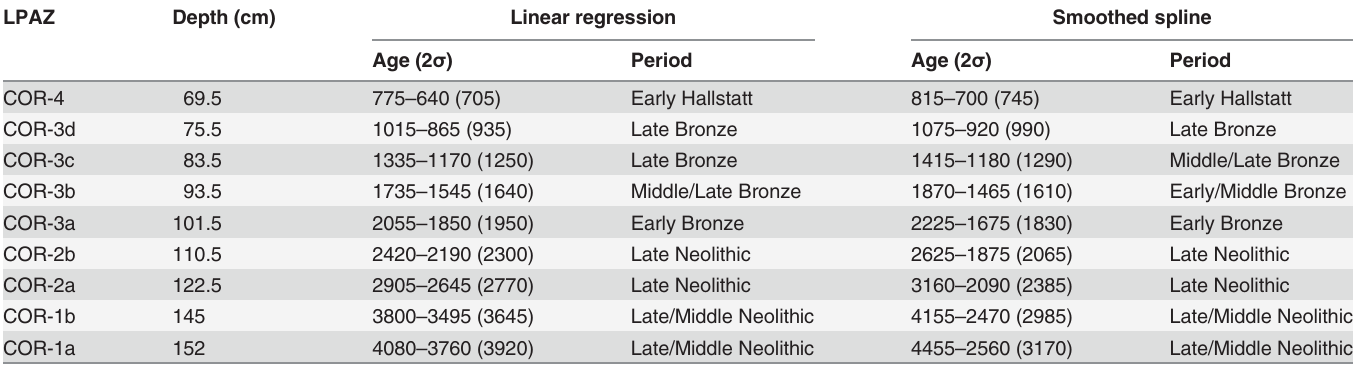
Table 4. Comparison of the two age-depth models generated in Fig. 4. Age ranges in the table are cal. BC. Numbers in parentheses reflect the me- dian age from each model. LPAZ Depth